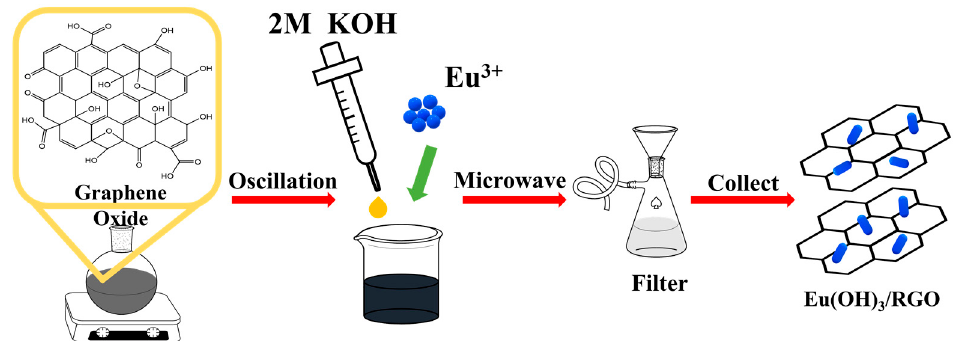
Figure 1. Schematic illustration of the synthesis process of the europium hydroxide (Eu(OH) 3 )/reduced graphene oxide (RGO) nanomaterial. KOH: Potassium hydroxide.